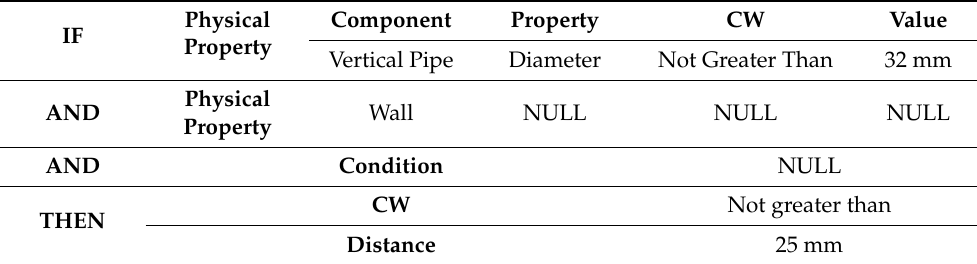
Table 3. An example of optimizing the component spacing rule.